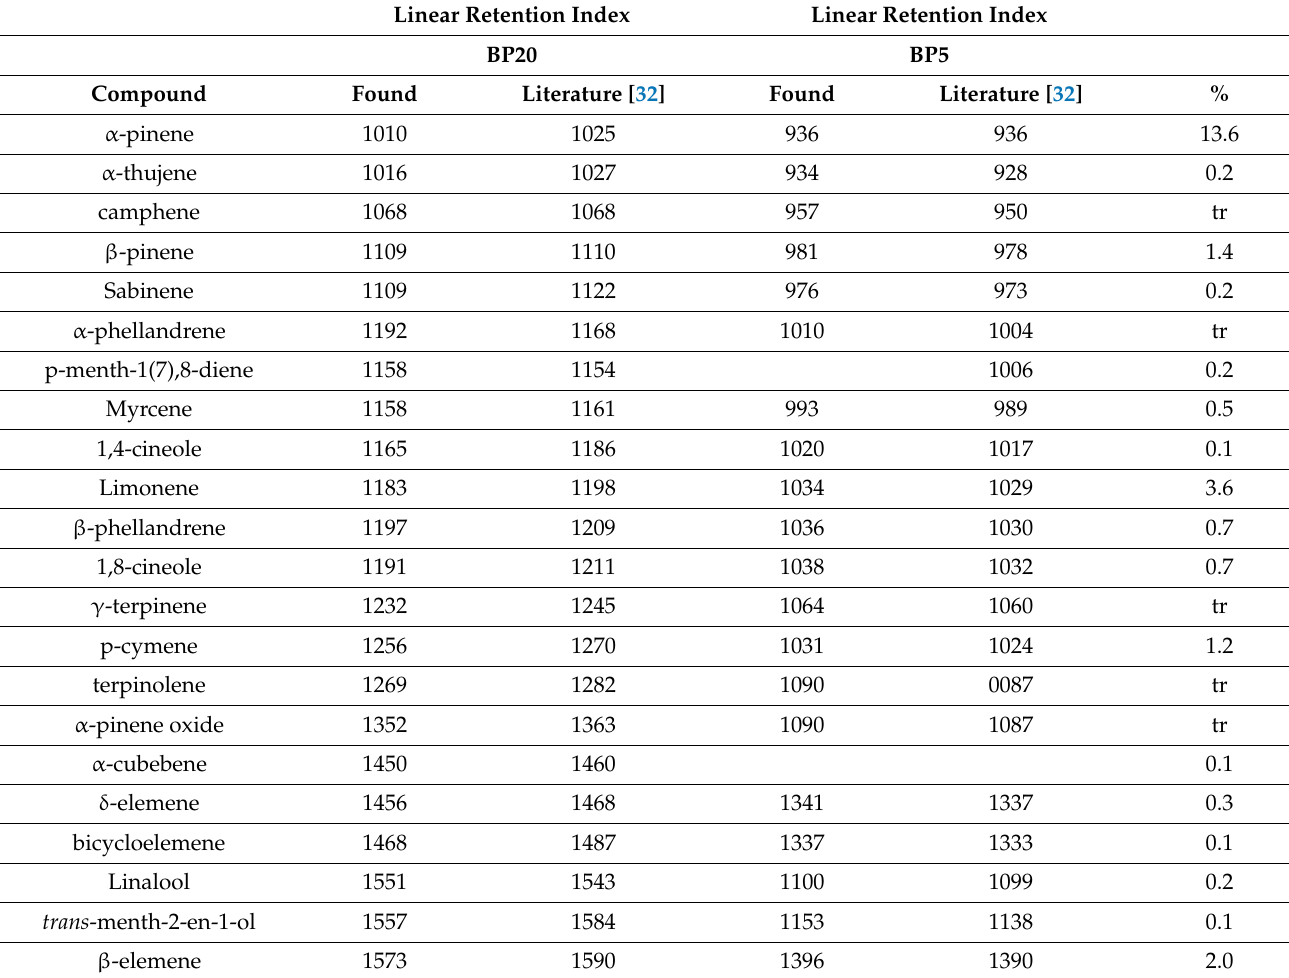
Table 1. Components identified in the leaf oil of Backhousia gundarara